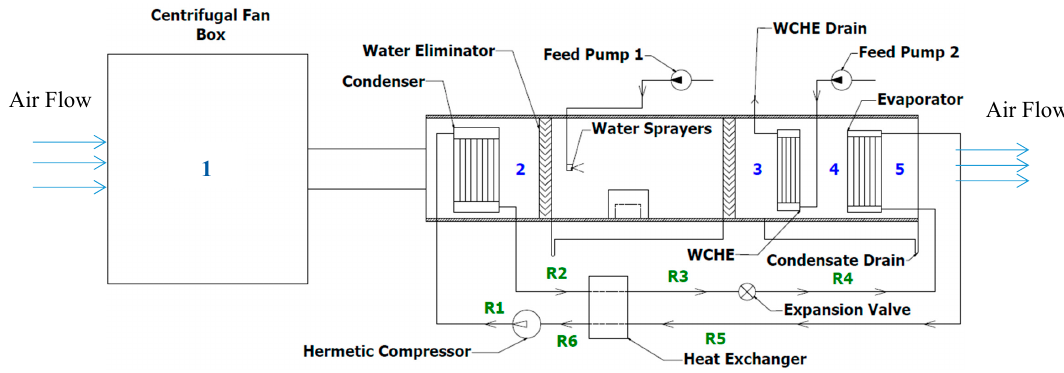
Figure 4. Schematic of the humidification–dehumidification desalination process.